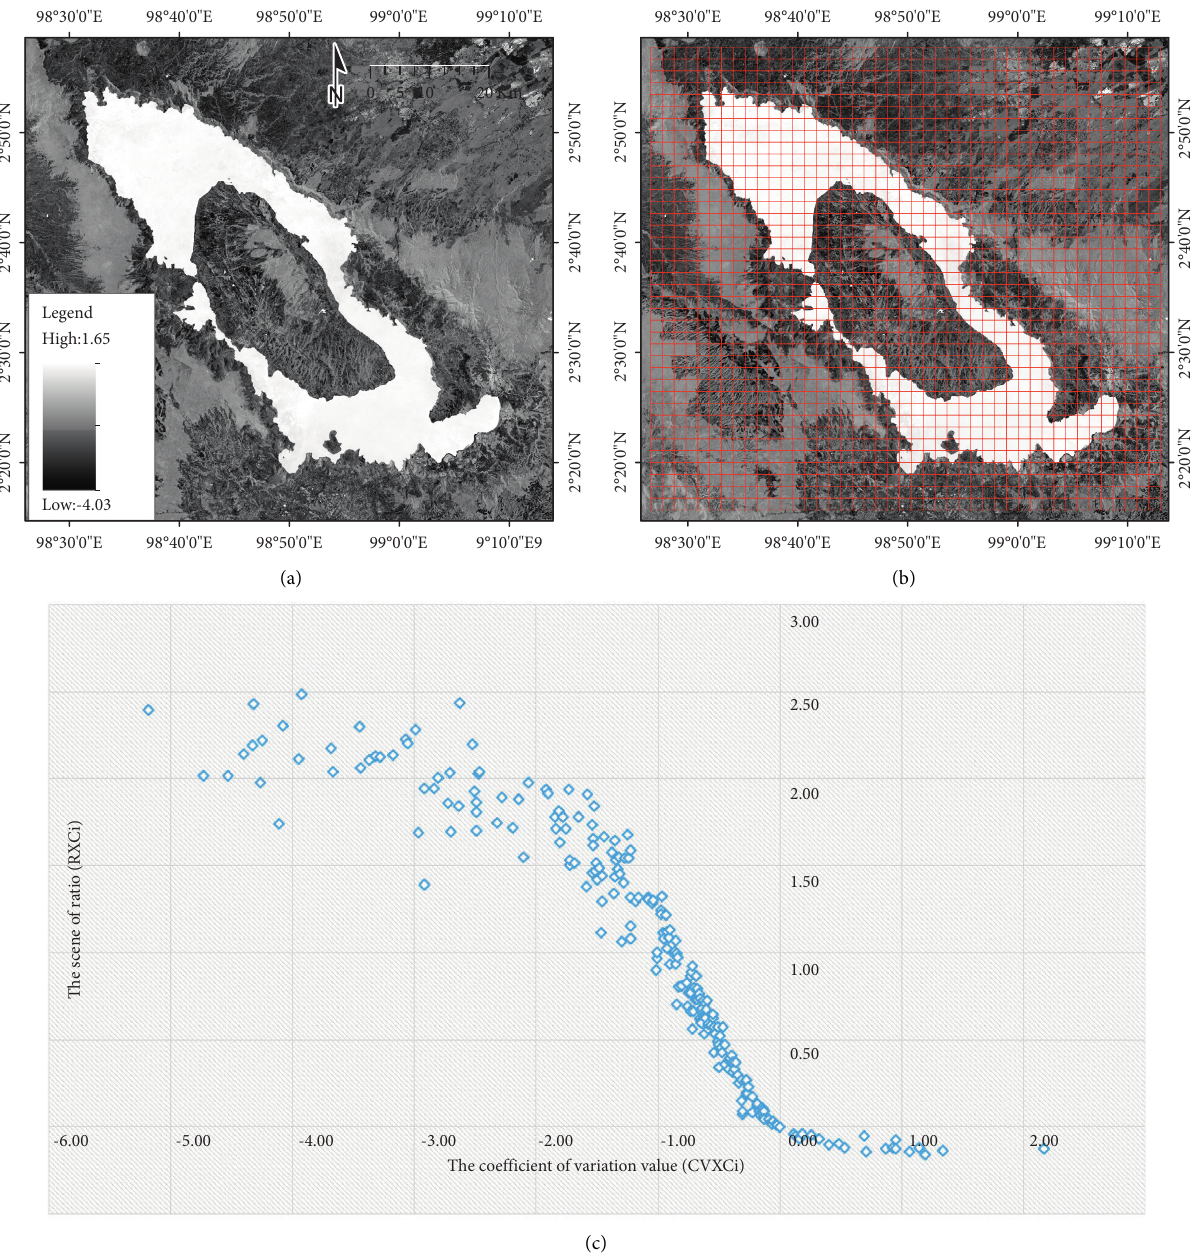
Figure 4: (a) Result calculation of the AWEI approach for (a) scene image and (b) split scene image with GIF at the size of 2 km × 2km; a total of 1677 split scene images were used in the study to calculate the local statistics parameters for each split scene image. (c) Measurement results of the coefficient of variation value of each split scene image plotted on the X -axis and the scene ratio value plotted on the Y